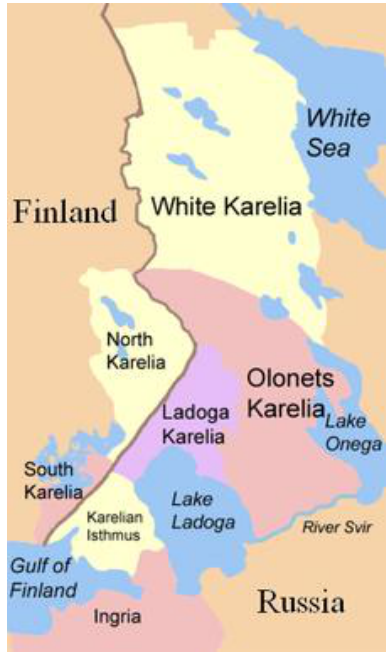
Figure 1. Many Karelias (Permission is granted to copy, distribute and/or modify this document under the terms of the GNU Free Documentation License , Version 1.2 or any later version published by the Free Software Foundation; with no Invariant Sections, no Front-Cover Texts, and no Back-Cover Texts. Subject to disclaimers.).